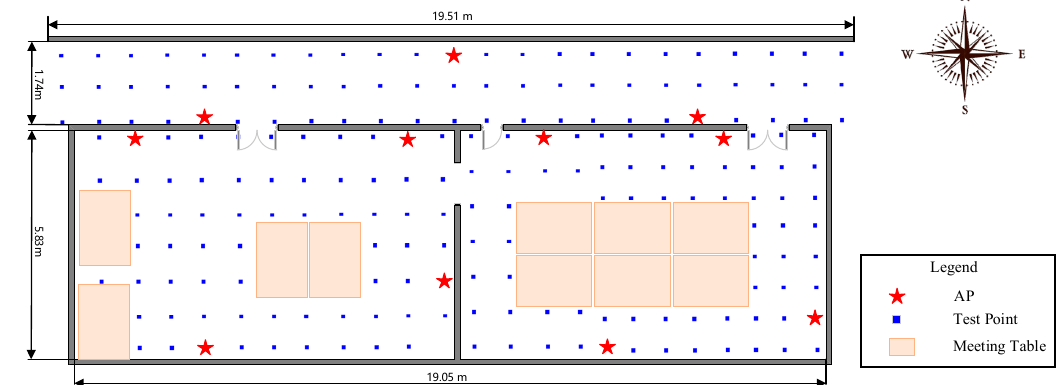
Figure 14. Experimental area.